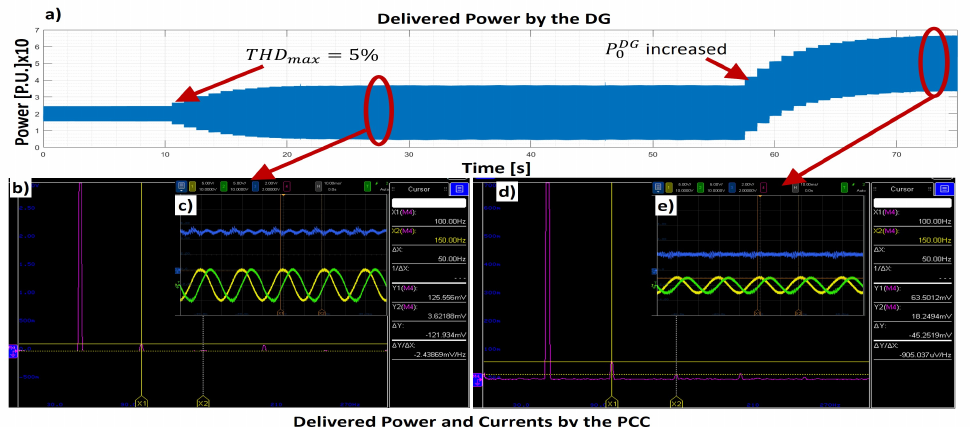
Figure 6. Power and currents delivered by the PCC and the DG for case 2: ( a ) DG power–time domain. ( b ) Frequency spectrum and ( c ) time domain PCC signals when THD max was settled to 5%. ( d ) Frequency spectrum and ( e ) time domain signals when P DG 0